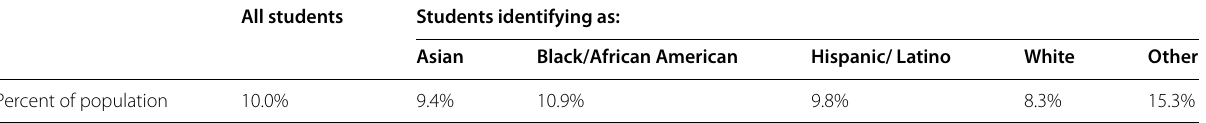
Table 2 PSI participation as a percent of students enrolled in PSI‑supported courses, disaggregated by students’ self‑identified race/ ethnicity